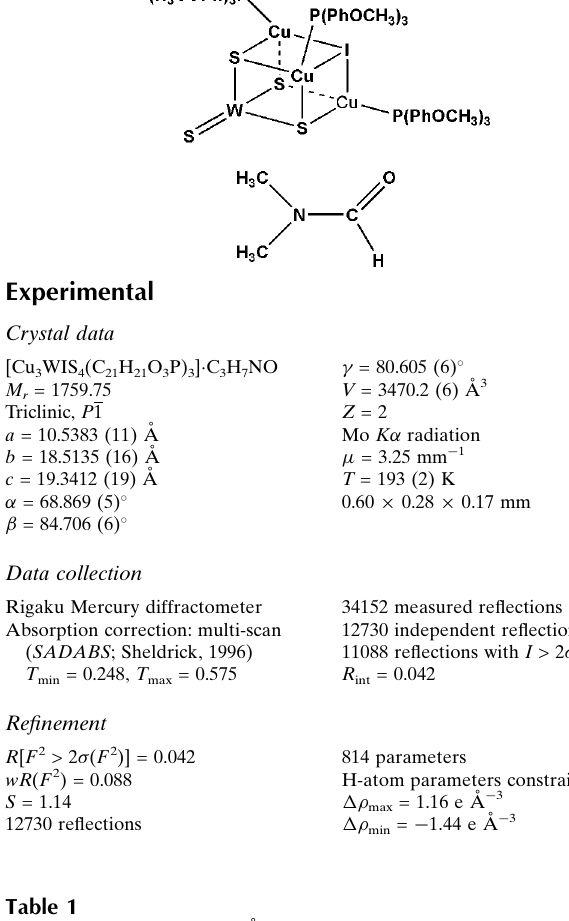
Rigaku Mercury diffractometer Absorption correction: multi-scan ( SADABS ; Sheldrick, 1996) T min = 0.248, T max = 0.575